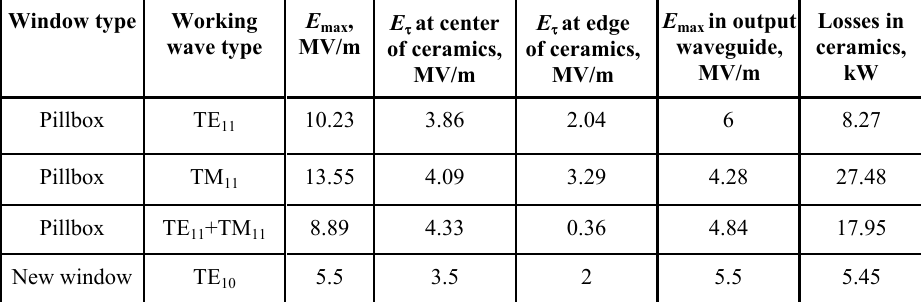
Table 1. Energy parameters at P = 40 MW at the center